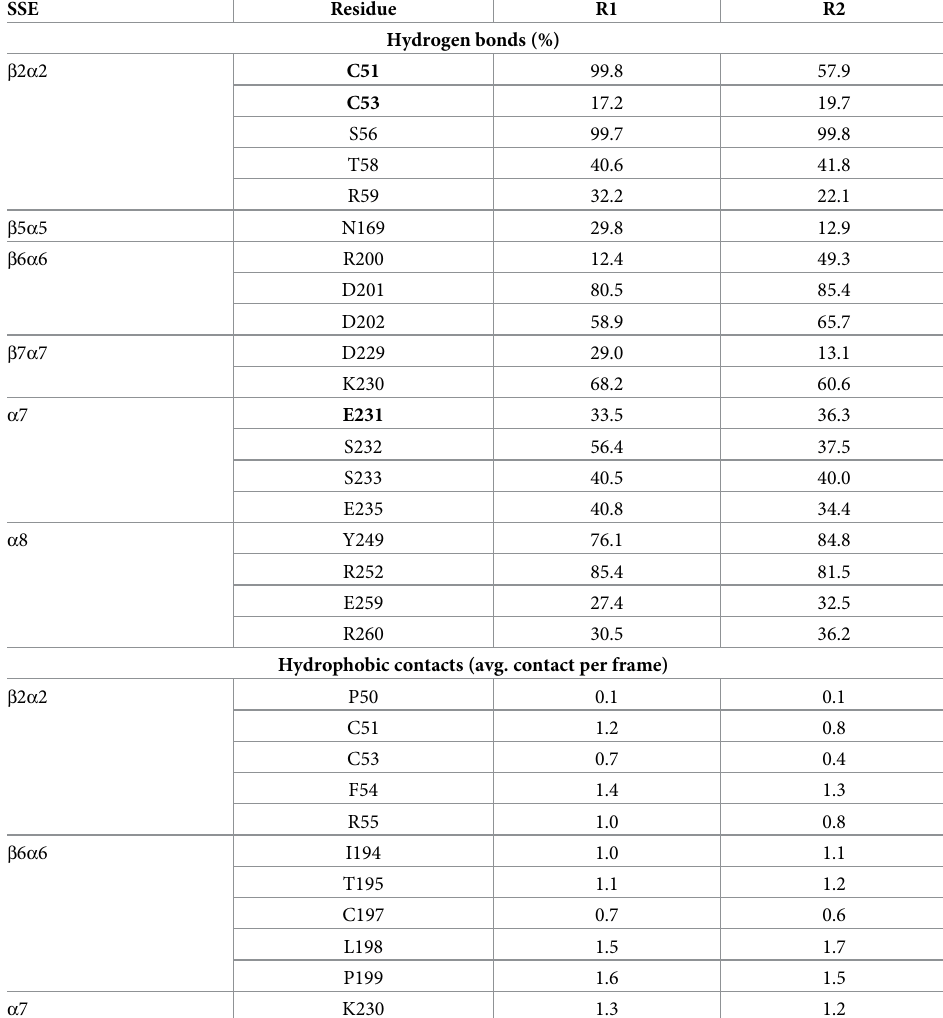
Table 3. Inventory of interactions between WT St_ β IB1 and a POPC:POPE bilayer. Hydrophobic contacts are given as average number of contacts per frame. Hydrogen bonds and cation- π occupancies are reported as percentages. Residues in bold indicate hydrogen bonds involving the amino acid backbone. Underlined residue names indicate hydrogen bonds involving the ethanolamine headgroup. SSE Residue R1